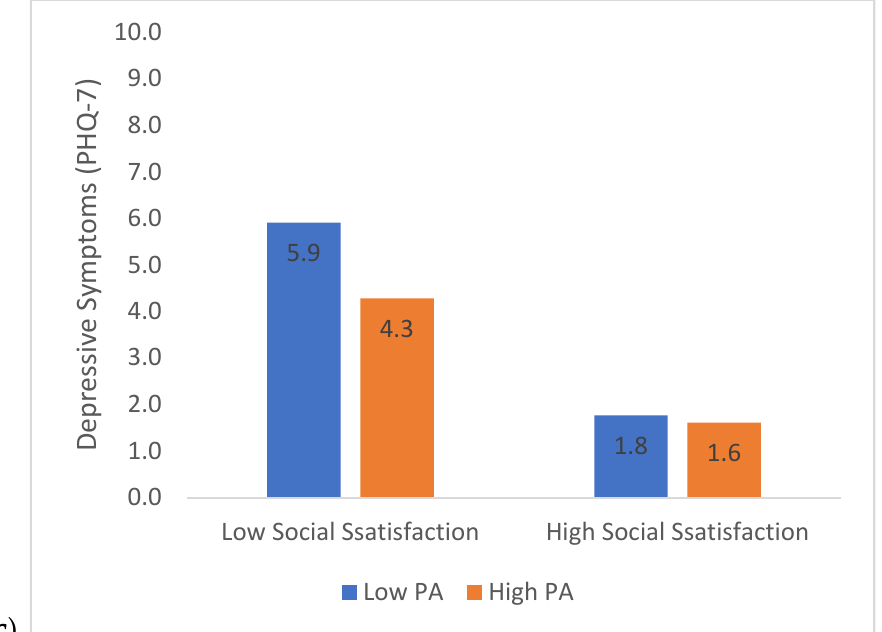
Figure 2. Estimated depressive symptoms (PHQ-7 scores) as a function of the association between social satisfaction and ( a ) total wake time (TWT), ( b ) sleep quality (SQ), and ( c ) physical activity (PA). High and low social satisfaction scores represent ± 2 SD from the sample mean ± 2 SD from the sample mean was also used to estimate high and low values for TWT, SQ, and PA.